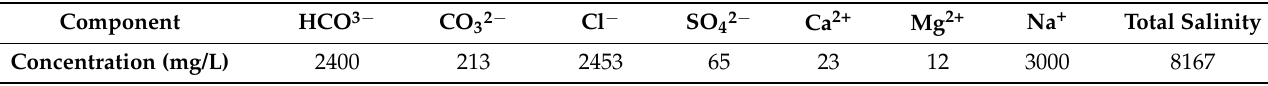
Table 1. Formulation water formula for